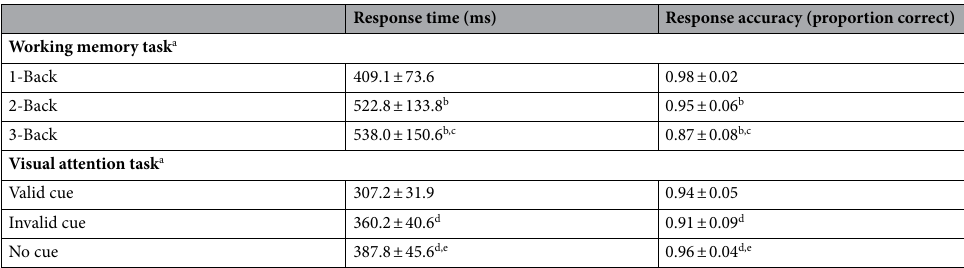
Table 3. Cognitive measures for participants with valid weekly sleep and valid sleep measured the night prior to cognitive testing. Results presented as median ± interquartile range due to skewed distributions. a Differences evaluated using mixed effect regression of transformed variables with Bonferroni post hoc correction for multiple comparisons. b Significantly different than 1-back load. c Significantly different than 2-back load. d Significantly different than valid cue presentation. e Significantly different than invalid cue